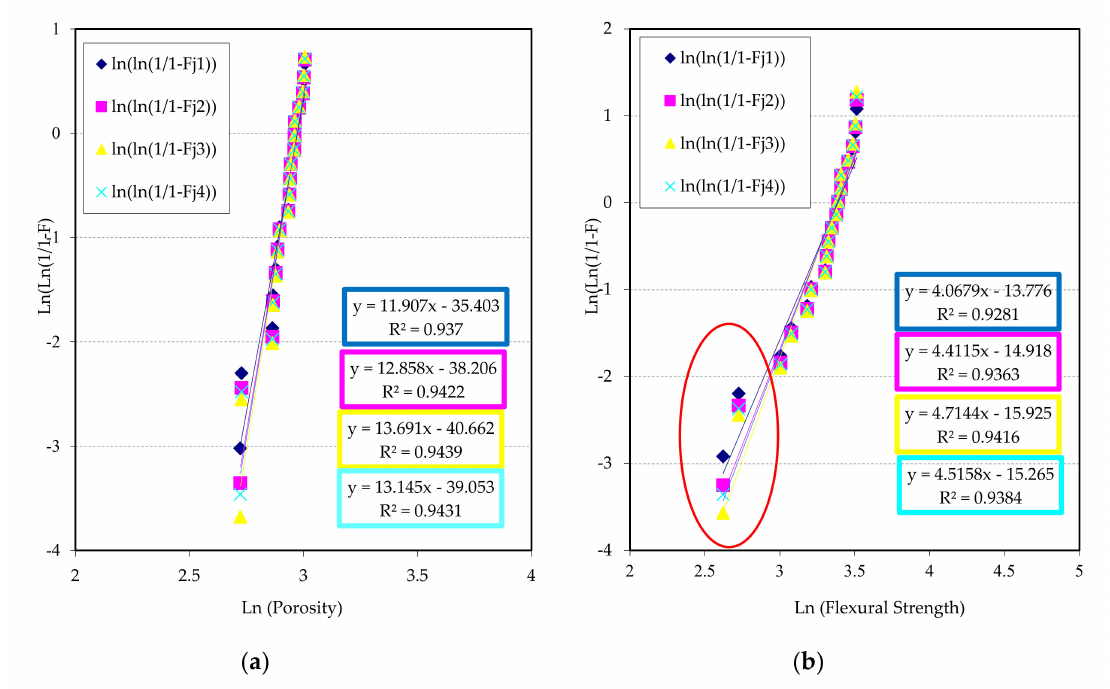
Figure 12. Weibull plots for chosen failure estimators using porosity as a key property: ( a ) G1 series and ( b ) G2 series.